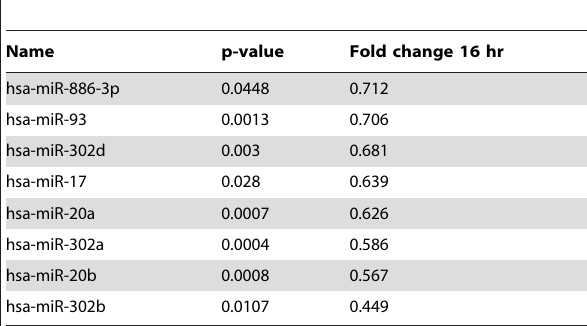
Table 4. Down-regulated miRNA species in H1 hESC at 16 hr post 1 Gy of IR exposures (p , 0.05).